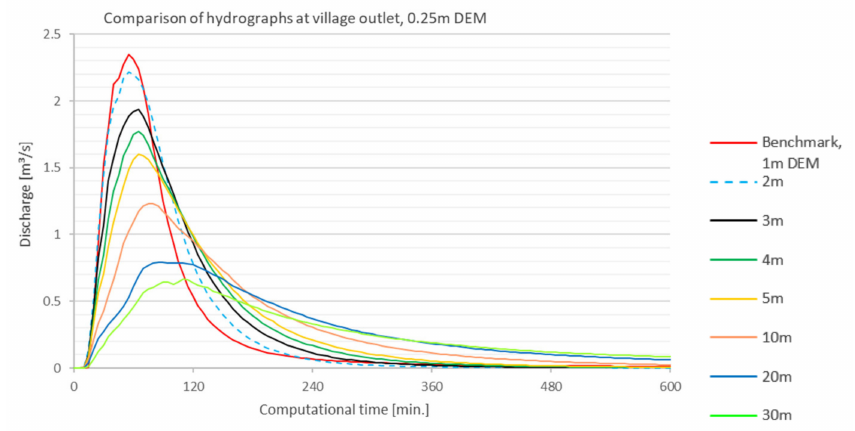
Figure 12. Overview of hydrographs at the outlet of the catchment for DEM 0.25 m and different mesh resolutions (mesh: colored